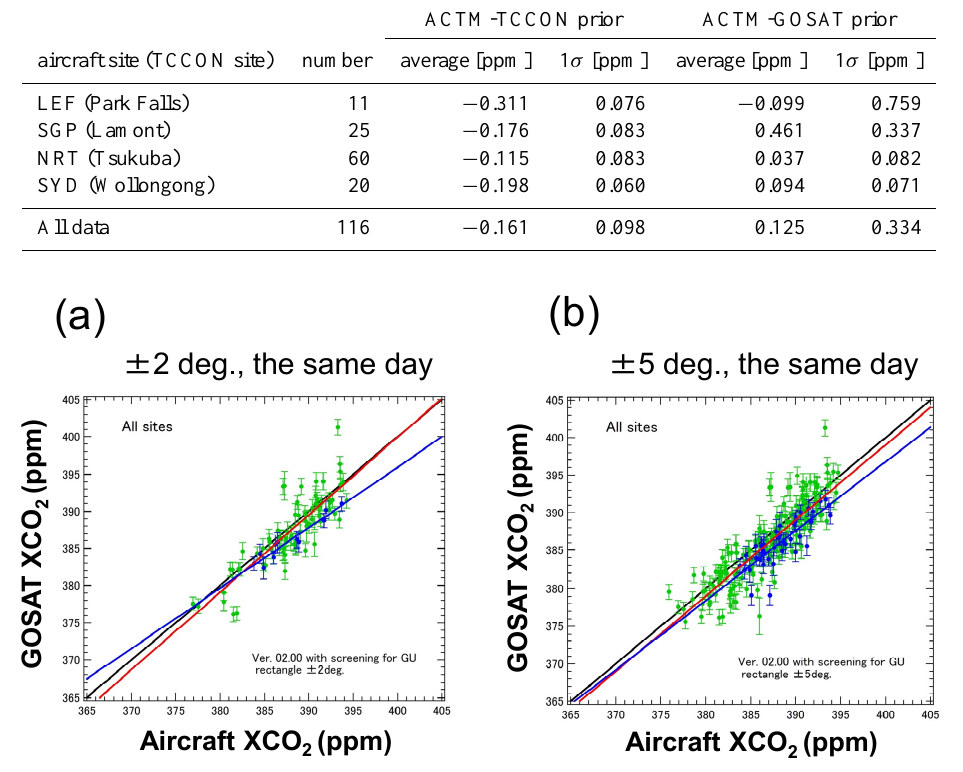
Fig. 6. Scatter diagrams between GOSAT XCO 2 observed within (a) ± 2 and (b) ± 5 ◦ latitude/longitude boxes centered at each aircraft observation site and aircraft-based XCO 2 with the application of CAK measured on a GOSAT overpass day. Green and blue dots indicate GOSAT XCO 2 obtained over land and ocean regions, respectively. Red and blue lines denote the regression lines with statistical significance at the 95% level over land and ocean regions, respectively. The one-to-one lines are plotted as black lines.